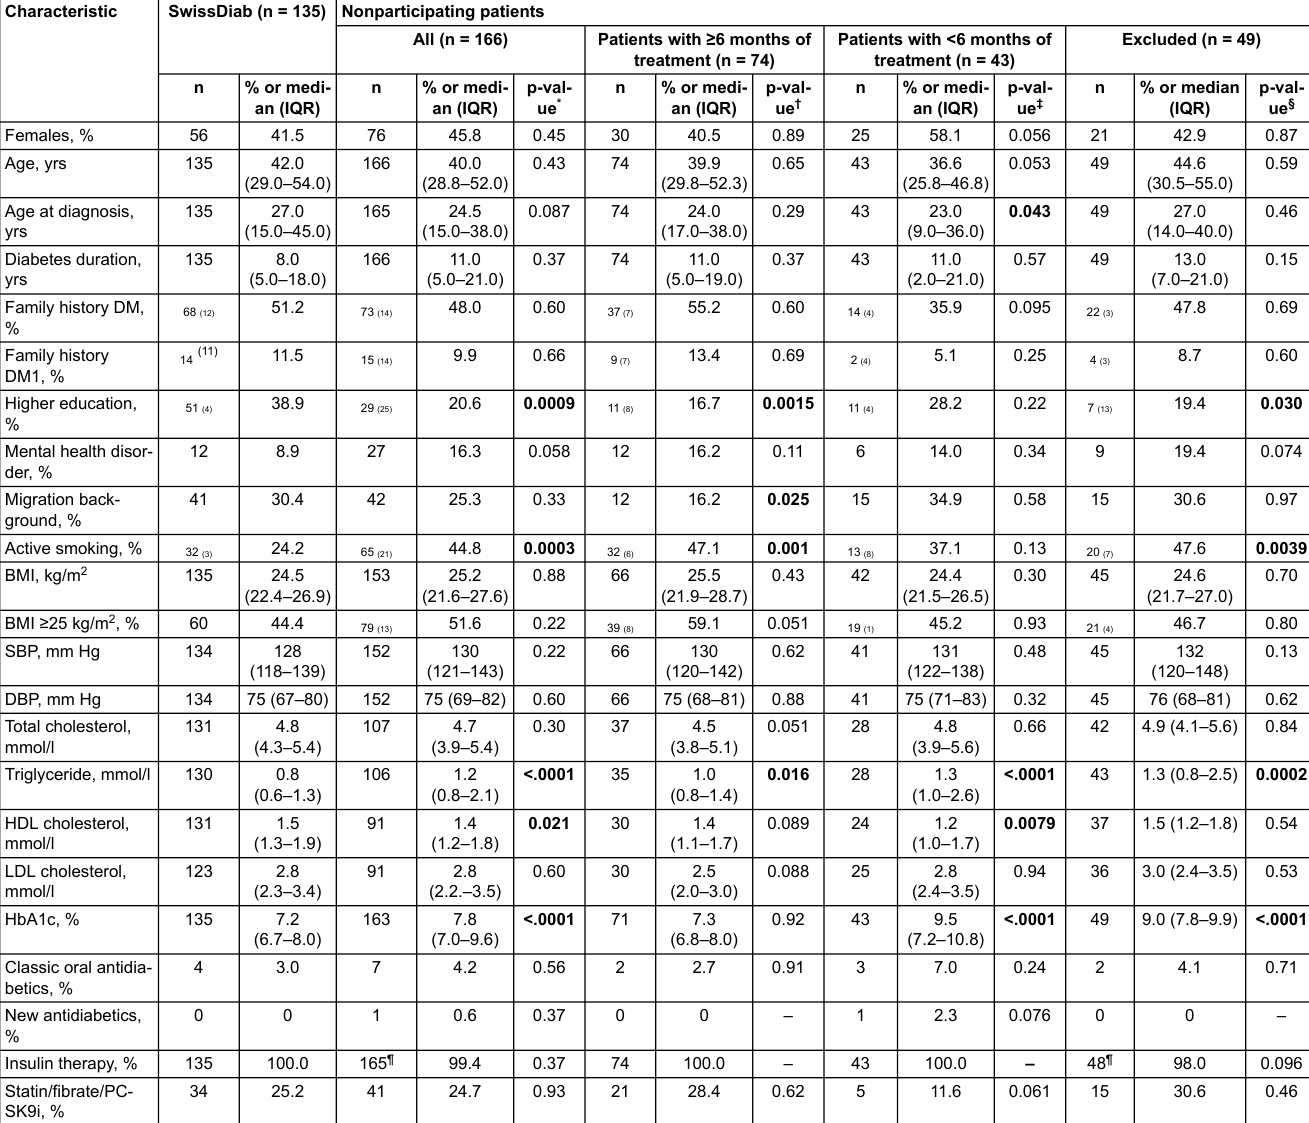
Table 1: Characteristics of SwissDiab participants and nonparticipating patients with DM1. Characteristic